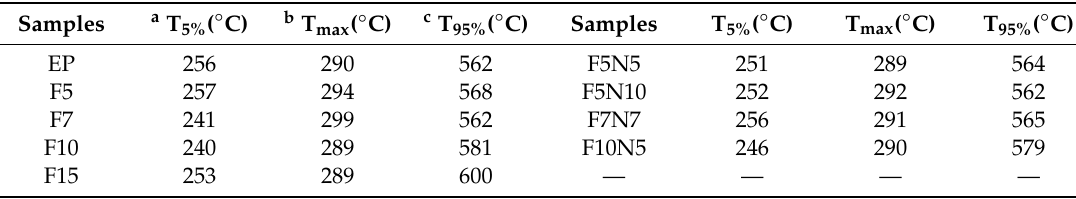
Table 3. T 5% , T max and T 95% of di ff erent samples